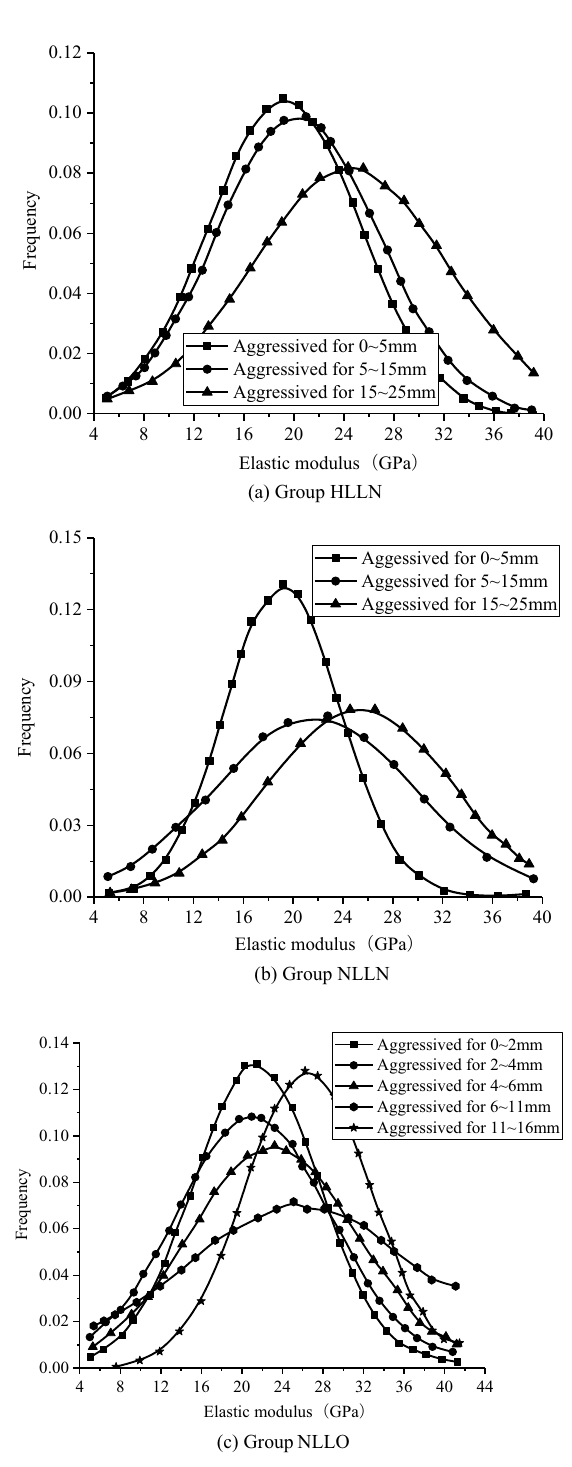
Figure 6. Probability fitting diagram of elastic moduli at different aggressived